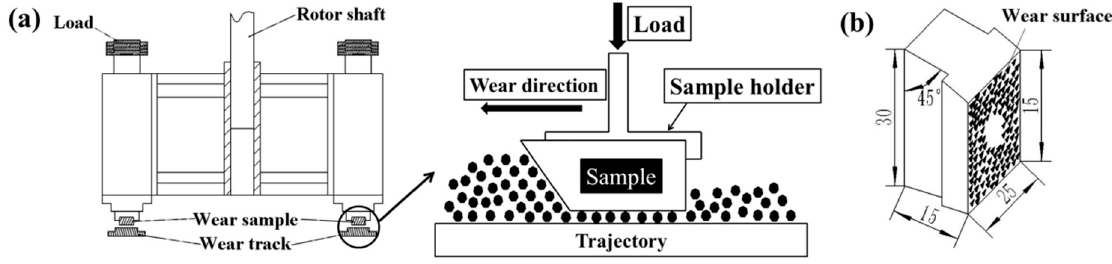
Figure 2. Schematic diagrams of the three-body abrasive wear system: ( a ) Wear system, ( b ) Wear sample. Table 1. Test scheme.